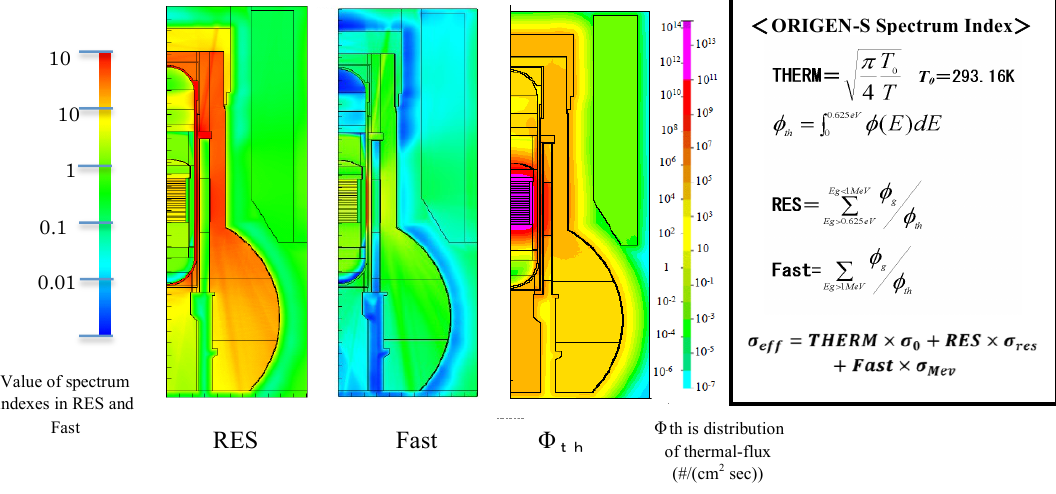
Figure 4 Distribution of ORIGEN spectrum